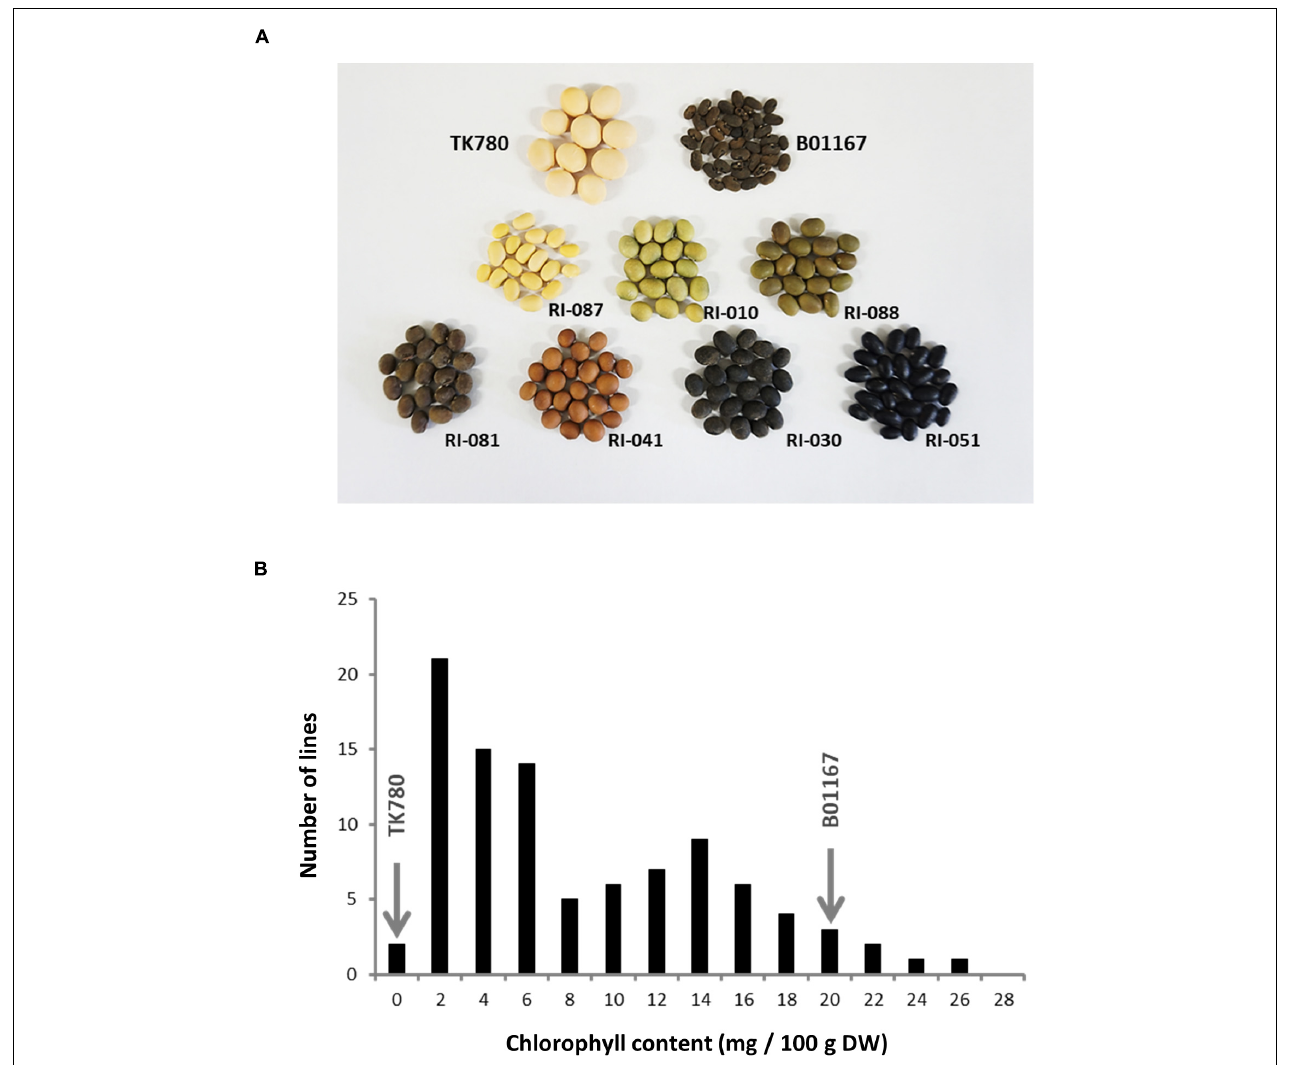
FIGURE 2 | Colors and chlorophyll contents of the seed coat in representative RILs generated from a cross between cultivated and wild soybeans and parental plants. (A) Representative RILs generated from a cross between a wild soybean accession (B01167) and a breeding line (TK780). RILs (F 8 generation) and parental plants were grown in the greenhouse at Hokkaido University. The seeds in the middle and bottom rows show the seed coat colors of representative RILs. The number at the bottom right of each RIL seed indicates the line number of the RIL. (B) Frequency distribution of the chlorophyll content in the seed coats of RILs and parental plants. The arrows denote the chlorophyll content of parental